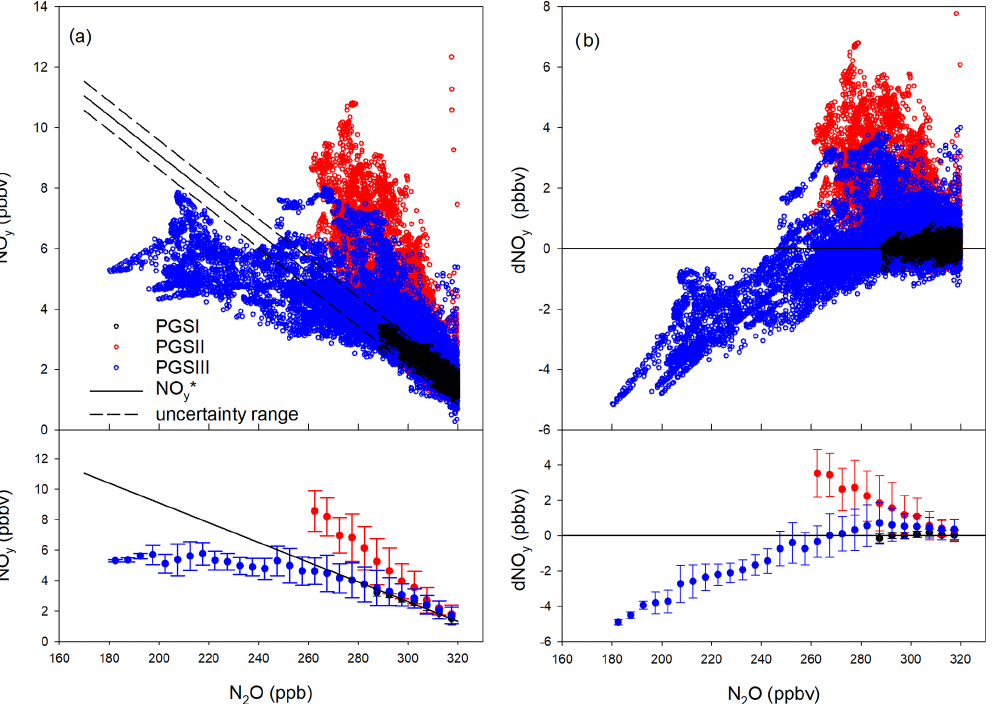
Figure 7. (a) NO y and NO ∗ y versus N 2 O for all POLSTRACC flights. The three phases of the POLSTRACC mission are colour coded. Values are additionally given as means (averaged over 5ppb N 2 O intervals) along with standard deviation. Calculated NO ∗ y is shown as a solid line; the uncertainty range is indicated by dashed lines. (b) Same as (a) but with dNO y versus N 2 O.